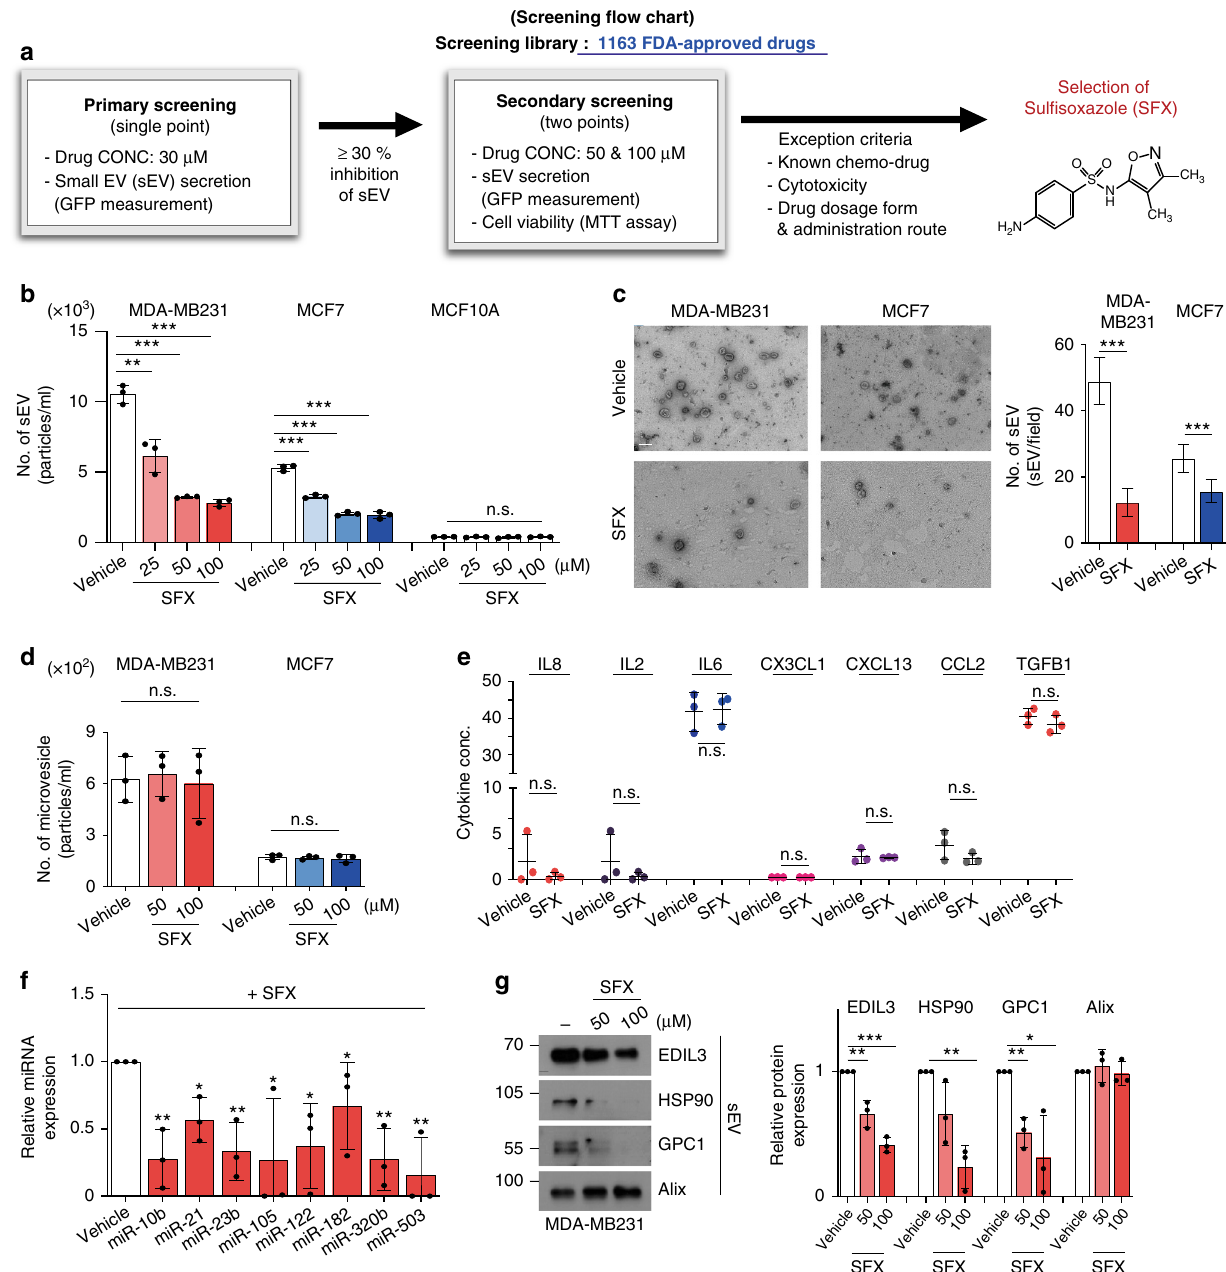
Fig. 1 SFX inhibits the secretion of sEV from breast cancer cells quantitatively and qualitatively. a Screening fl ow chart of primary and secondary screenings with some exclusion criteria to identify an inhibitor of sEV secretion, sul fi soxazole. b The number of secreted sEV with the indicated concentrations of SFX. n = 3. c Left, electron microscopy image. Scale bar, 100 nm. Right, Quanti fi cation of the number of secreted sEV. Randomized fi elds were captured and counted. n = 30. d Measurement of the microvesicle concentration by nanoparticle tracking analysis (NTA). n = 3. e Measurement of soluble cytokines secreted from MDA-MB231 cells. n = 3. f qRT-PCR analysis of the indicated miRNAs in MDA-MB231 cells after treatment of 100 μ M SFX. n = 3. The GEO accession number of miRNA microarray set is GSE124320. g Immunoblot of various proteins in MDA-MB231 cell-derived sEV. Equal amounts of sEV protein (10 μ g) were loaded per lane. n = 3. Experiments were performed with 95% con fl uent cells. Signi fi cance was determined using an unpaired two- tailed Student ’ s t- test. *** p < 0.001, ** p < 0.005, and * p < 0.05. Error bar, SD. Source data ( b – g ) are provided as a Source Data fi